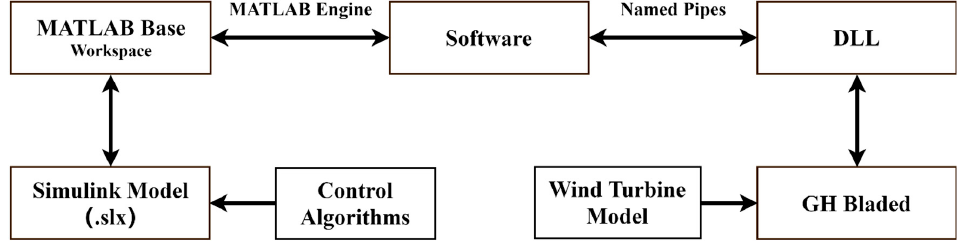
Figure 3. Data flow diagram of interactive software.